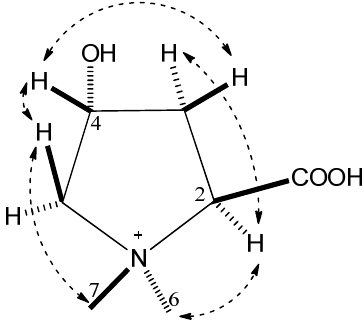
Figure 4. NOE correlation of compound 4.